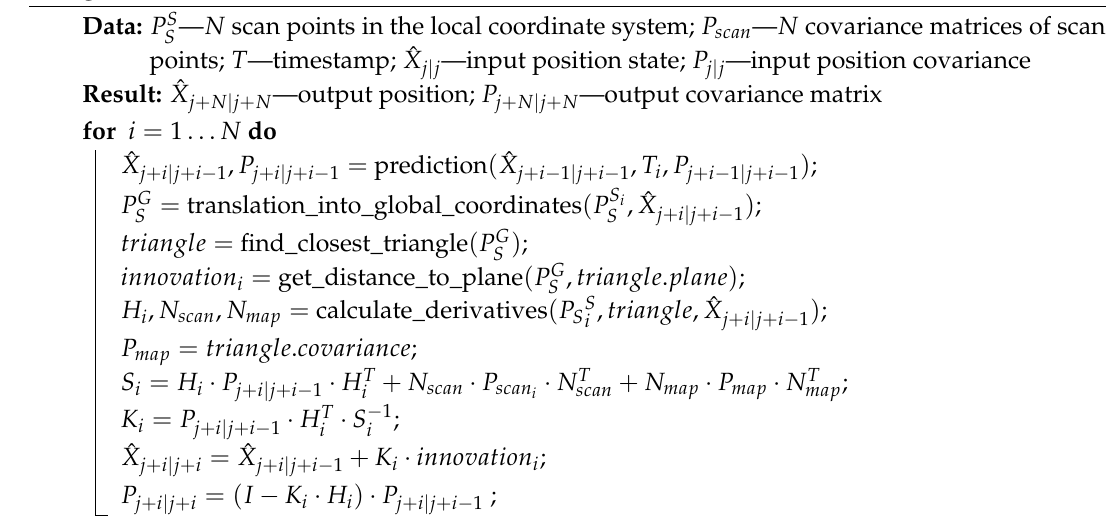
Algorithm 2: Serial Kalman